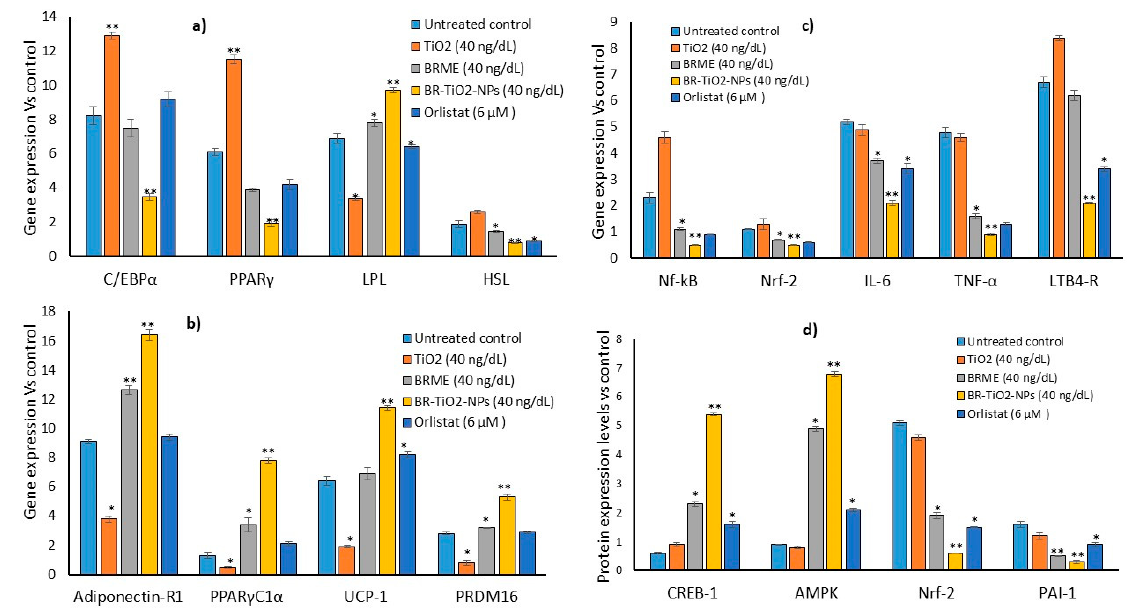
Figure 8. Adipogenesis ( a ), mitochondrial thermogenesis ( b ), and adipocytokine ( c )-related gene expression levels and mitochondrial oxidative capacity signaling protein ( d ) levels in the untreated control adipocytes and the adipocytes treated with TiO 2 , BRME, and BR-TiO 2 -NPs for 14 days. Each value is a mean ± SD ( n = 6). * Significant at p ≤ 0.05 and ** highly significant at p ≤ 0.001, by comparison with the untreated control.